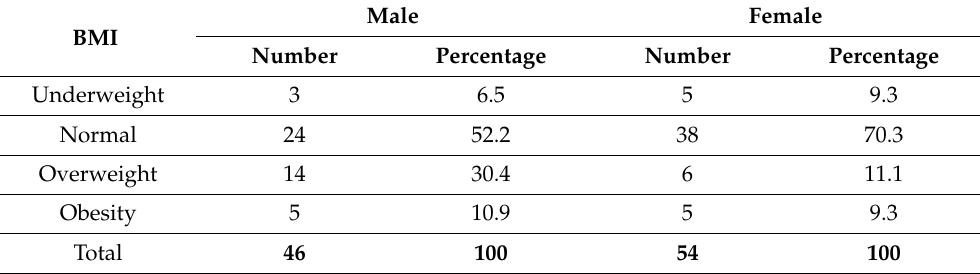
Table 2. Distribution of study participants according to the